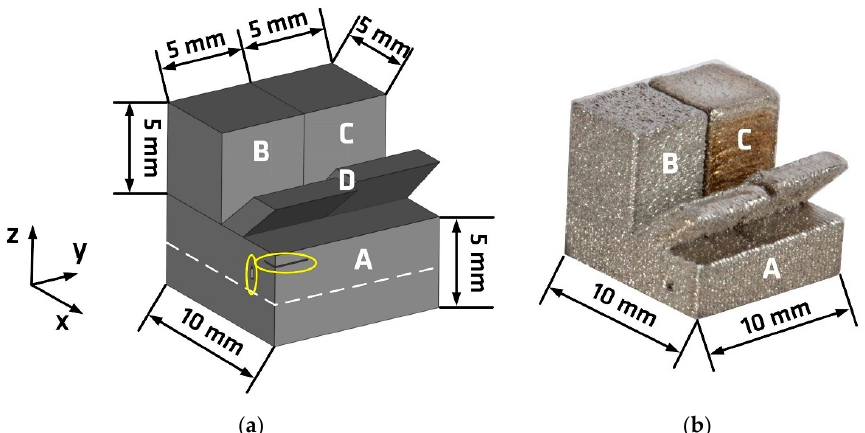
Figure 2. ( a ) Schematic of the specimen; volumes A, B and C were processed using different volume energy densities; volume D consisted of two ramps inclined by 40° and 45°. The white dotted line displays the cutting plane for part removal. The yellow circles enclose artificial defects. ( b ) Macroscopic photography of the specimen after cutting from the build base plate. The chapter 3, “Results and discussion”, focuses on volumes A, B and C.